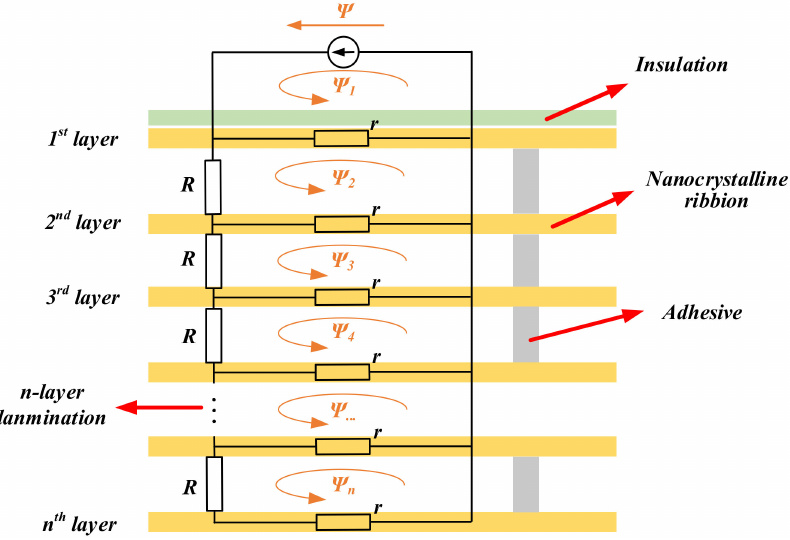
Figure 24. Flux distribution model for laminated core